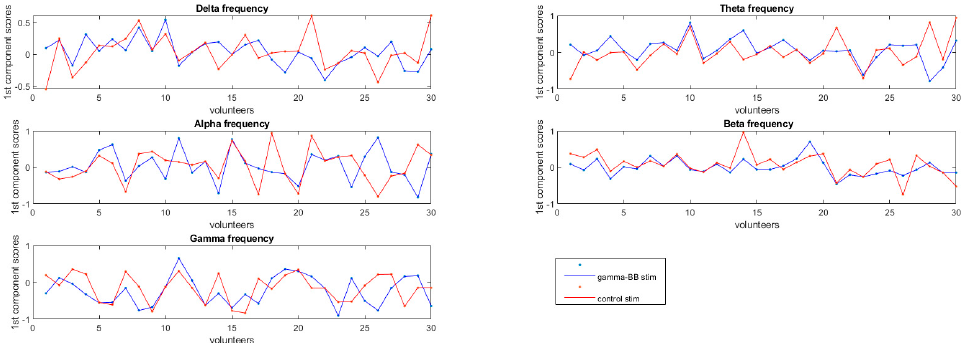
Figure 3. Plot of the scores of the first component per volunteer for the stimulation phase in a rest